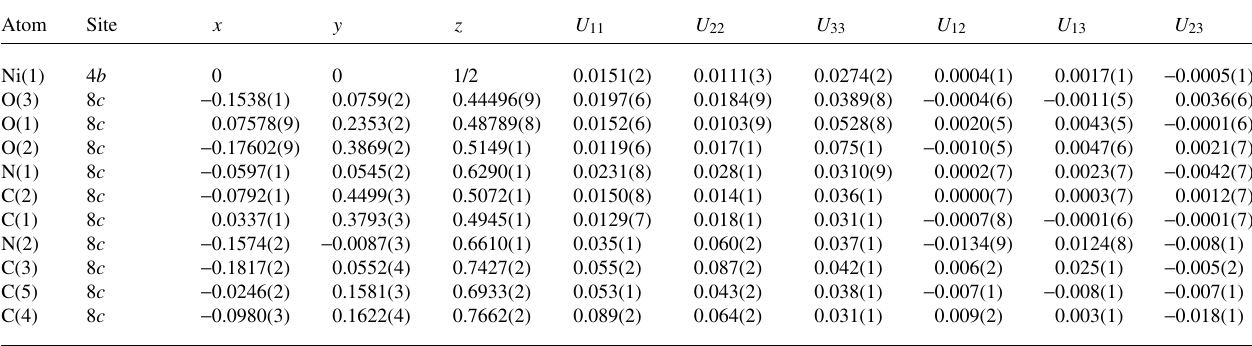
Table 3. Atomic coordinates and displacement parameters (in Å 2 )